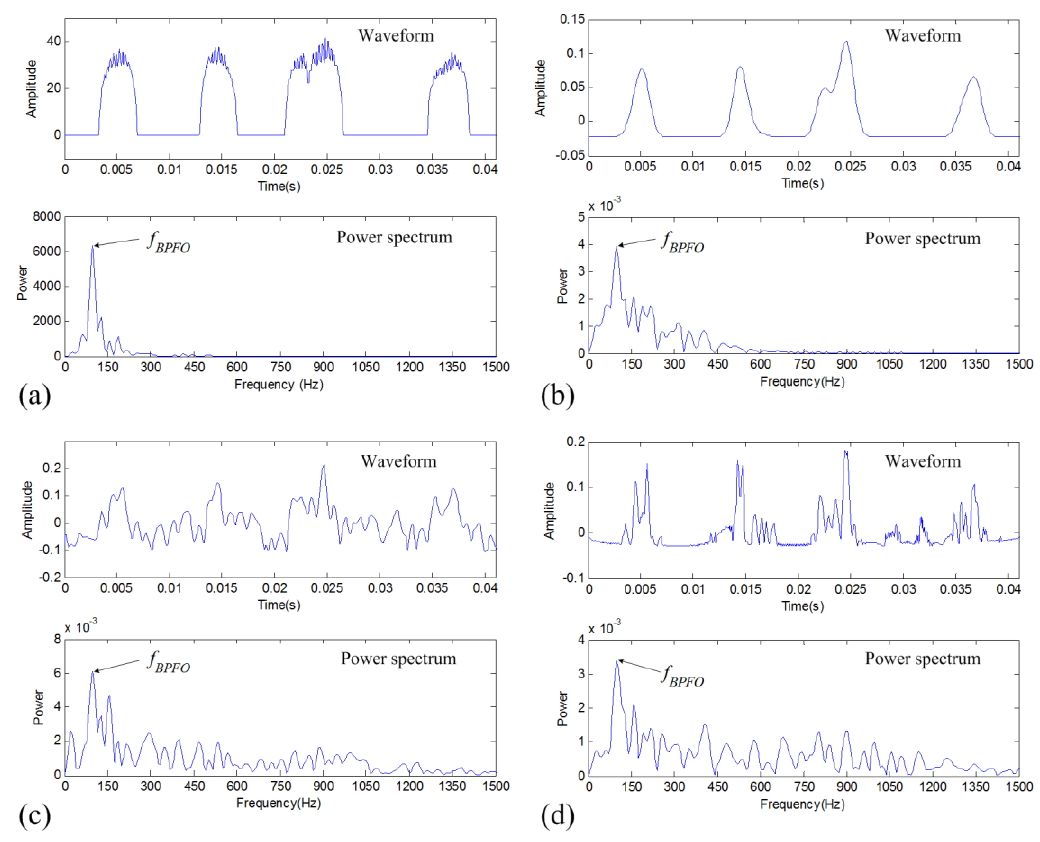
Figure 12. Fault diagnosis results of the outer-race defective vibration signal: ( a ) FPTS spectrum of TFM-based denoised signal; ( b ) envelope spectrum of TFM-based denoised signal; ( c ) envelope spectrum of band-pass filtered signal; and ( d ) envelope spectrum of DWT-based denoised